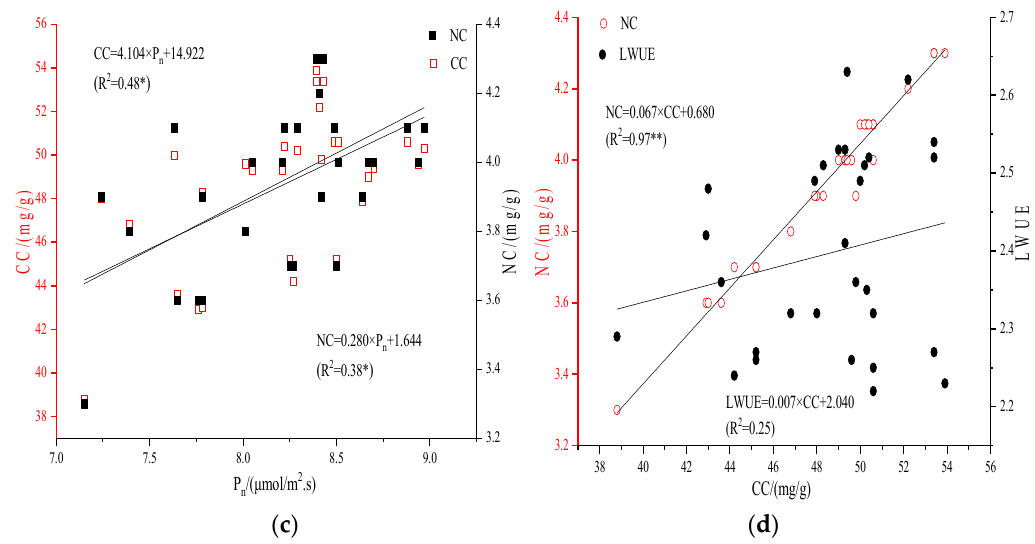
Figure 6. Quantitative relations between physiological indicators and growth indexes. ( a ) The relationship between P n and T r , G s ; ( b ) The relationship between P n and I SD , I SL ; ( c ) The relationship between P n and CC, NC; ( d ) The relationship between CC and NC, LWUE.